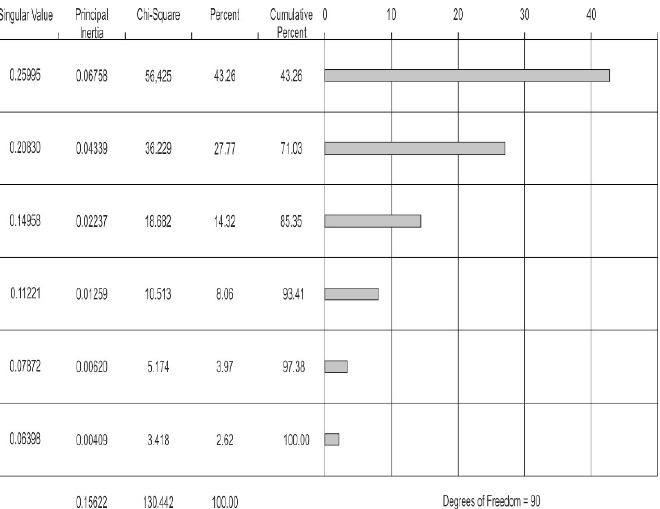
Figure 2. Inertia and chi-square decomposition for injuries related to felled and processed wood.